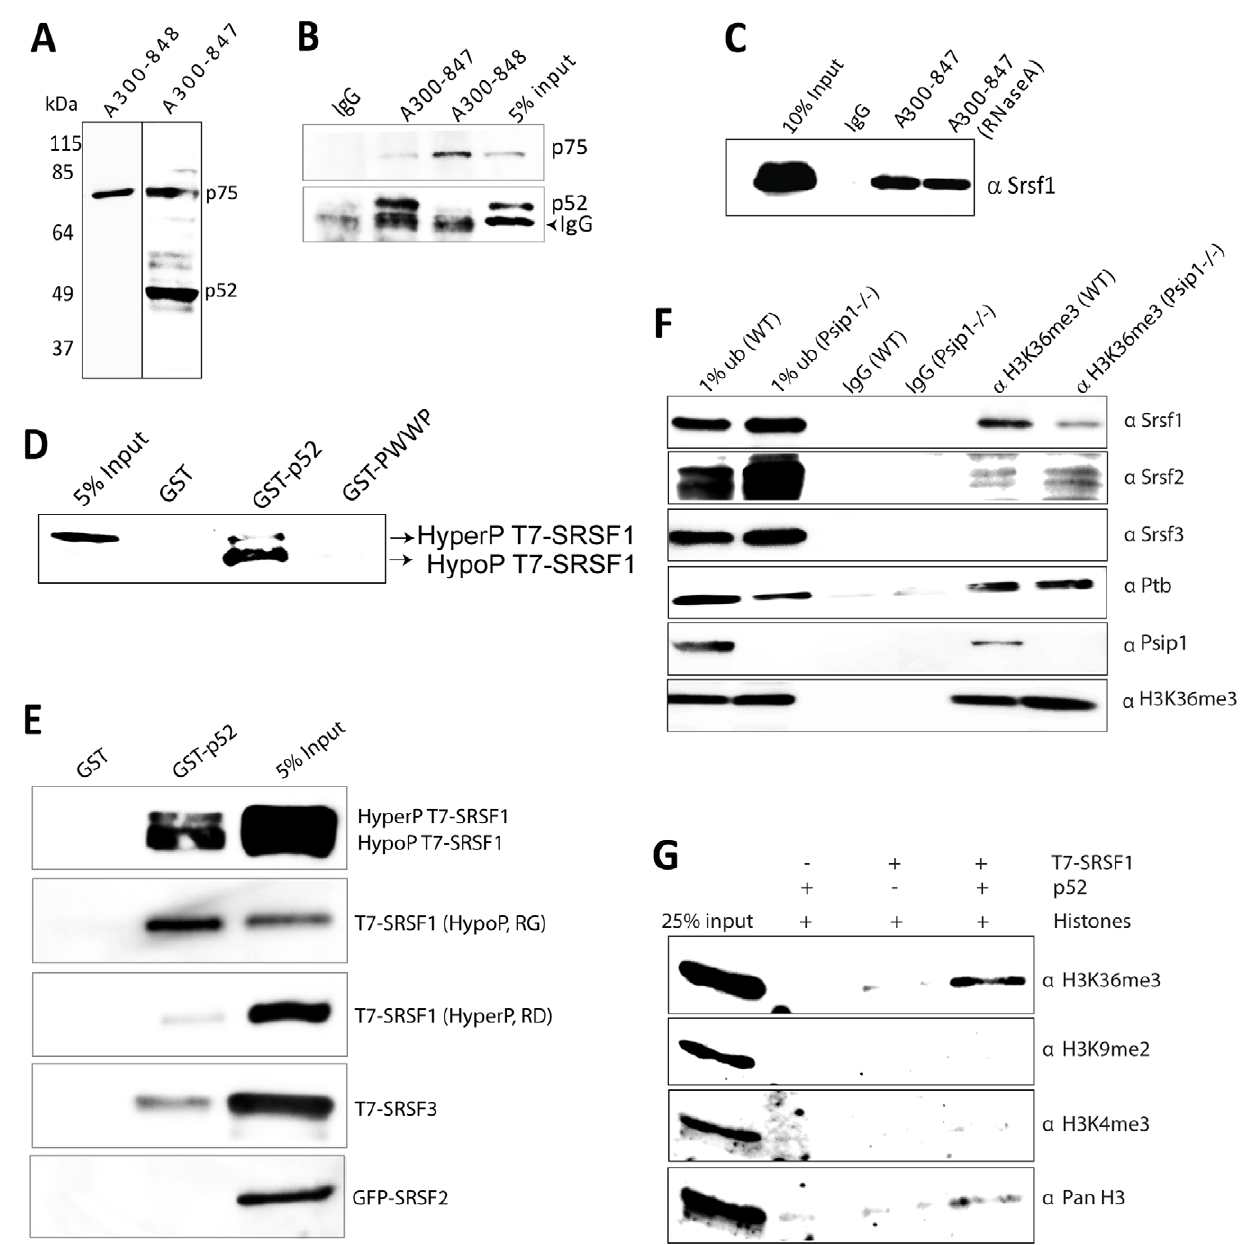
Figure 3. Immunoprecipitation of Psip1/p52 and p75. A) Immunoblot of NIH 3T3 nuclear extract with antibodies; A300-848 which recognizes only the p75 isoform of Psip1, and A300-847 which detects both p52 and p75. B) IPs with IgG, A300-847 and A300-848 from NIH 3T3 nuclear extracts, immunoblotted with antibodies recognizing p75 (A300-848) or p52 (A300-847). Input is 5% total extract. C) Immunoblot of A300-847 IPs with a SRSF1. IP was also performed in the presence of RNase A. Input is 10% of total extract and IgG served as a control. D) In vitro pulldown of 293T cell expressed T7-SRSF1 using GST-p52 and Psip1-PWWP and immunoblotted with a T7. Input is 5% of T7-SRSF1 and GST alone is control. E) In vitro pulldown with GST-p52 of; T7-SRSF1 and mutants that mimic its hypo-(RG) and hyper-phosporylation (RD), T7-SRSF3 and GFP-SRSF2. Immunoblotting was with a T7 or a GFP. F) ChIP with a H3K36me3 from wild-type (wt) and Psip1 2 / 2 MEFs immunoblotted with antibodies detecting Srsf1, Srsf2, Srsf3, PTB, Psip1 and H3K36me3. G) In vitro pulldown of HeLa core histones by T7-SRSF1 in the presence or absence of Psip1/p52 and immunoblotted with antibodies detecting pan H3, H3K36me3, H3K9me2 and H3K4me3. (Figure 4A) and is generally distributed in the nucleoplasm at interphase. Given the preponderance of splicing/RNA-binding proteins co- Table 1), we investigated the nuclear localizations of Psip1 isoforms. Antibody A300-848 revealed that, as for Psip1 gt/gt [22], endogenous p75 is associated with chromosomes in mitotic cells